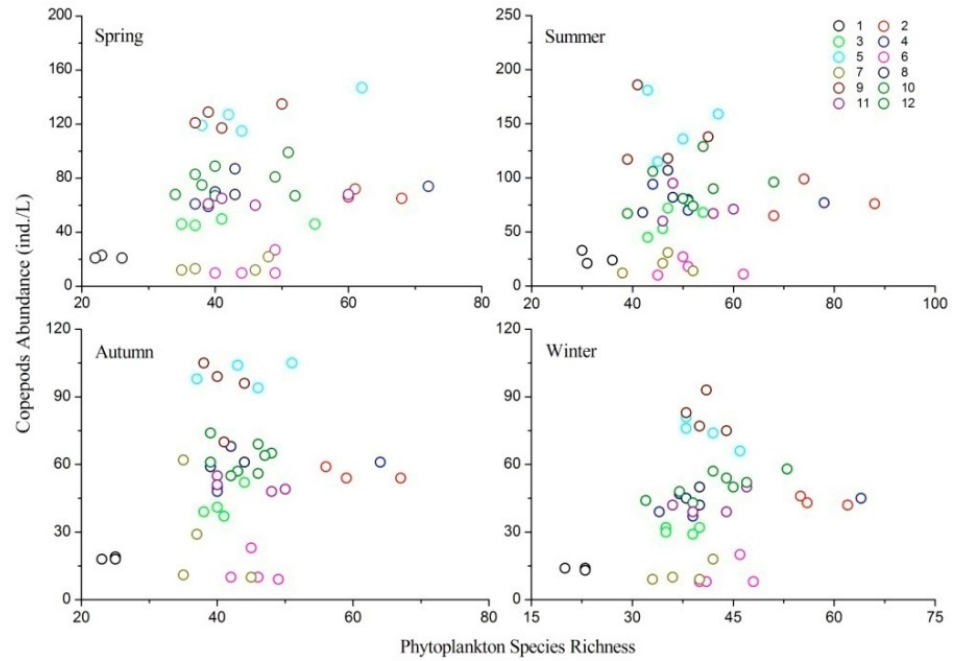
Figure 6. Relationships between phytoplankton species richness and copepod abundance in different seasons. Table 3. Linear Mixed Effects Model analyses for the relationship between phytoplankton species richness and copepod abundance in different seasons.